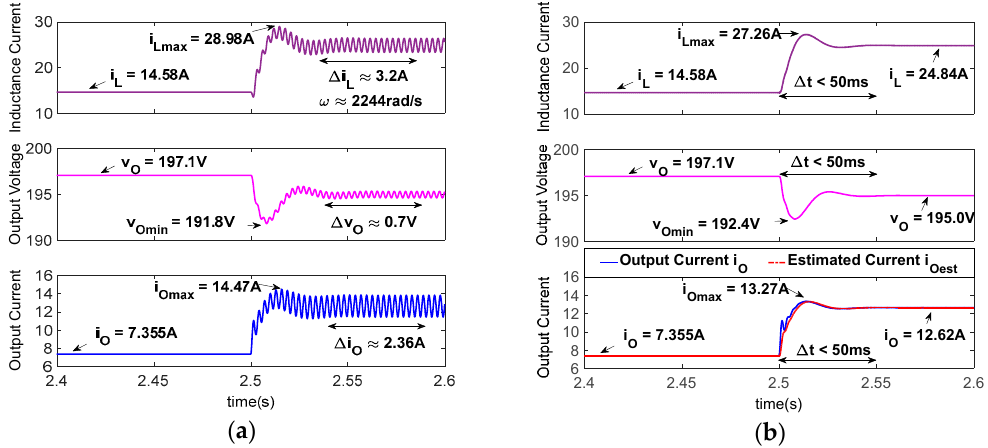
Figure 16. Comparative simulation results of the studied dc microgrid system with the CPL power change. ( a ) Conventional droop controlled system; ( b ) Proposed NDOB-VNI stabilizing strategy controlled system.